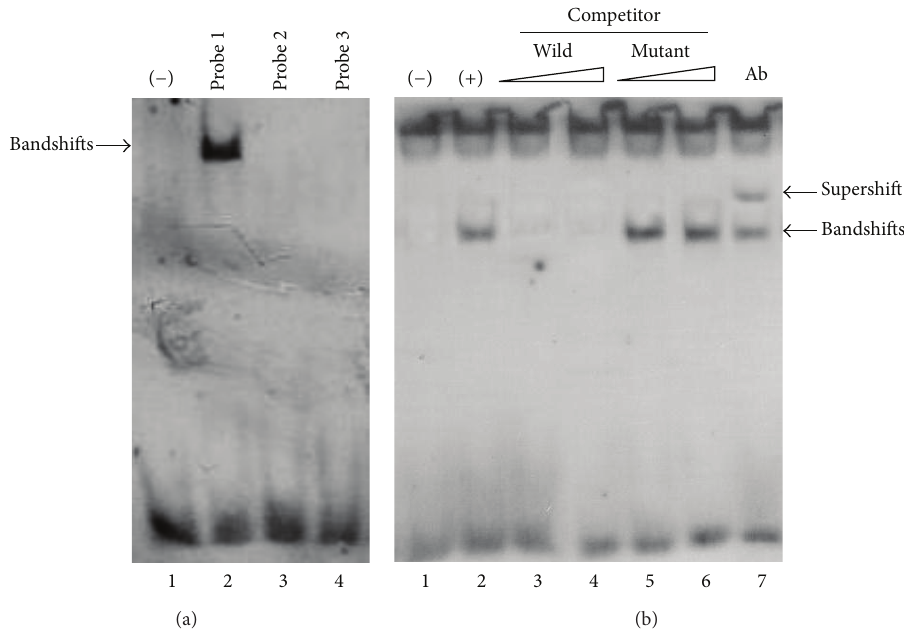
Figure 3: Identification of Elk-1 binding site in COX-2 promoter by electrophoretic mobility shift assay (EMSA). (a) Wild-type probe 1 ( − 87/ − 64 of COX-2 promoter) was incubated without (lane 1) or with (lane 2) INS-1 nuclear proteins. Wild-type probe 2 ( − 1300/ − 1277) (lane 3) or wild-type probe 3 ( − 1824/ − 1801) (lane 4) was incubated with INS-1 nuclear proteins. (b) Wild-type probe 1 was incubated without (lane 1) or with (lane 2) INS-1 nuclear proteins in the absence or presence of unlabelled probe 1 (lanes 3–6). Lanes 3 and 4 contain the wild-type probe 1, and lanes 5 and 6 contain the mutant probe 1, each at 50- and 100-fold molar excess, respectively. In lane 7, wild-type probe 1 was incubated with INS-1 nuclear proteins in the presence of Elk-1 antibody.